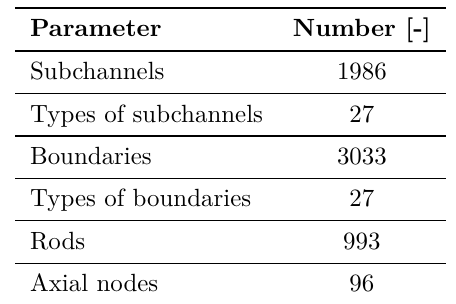
Table 1. Subchannel model of three fuel assemblies.